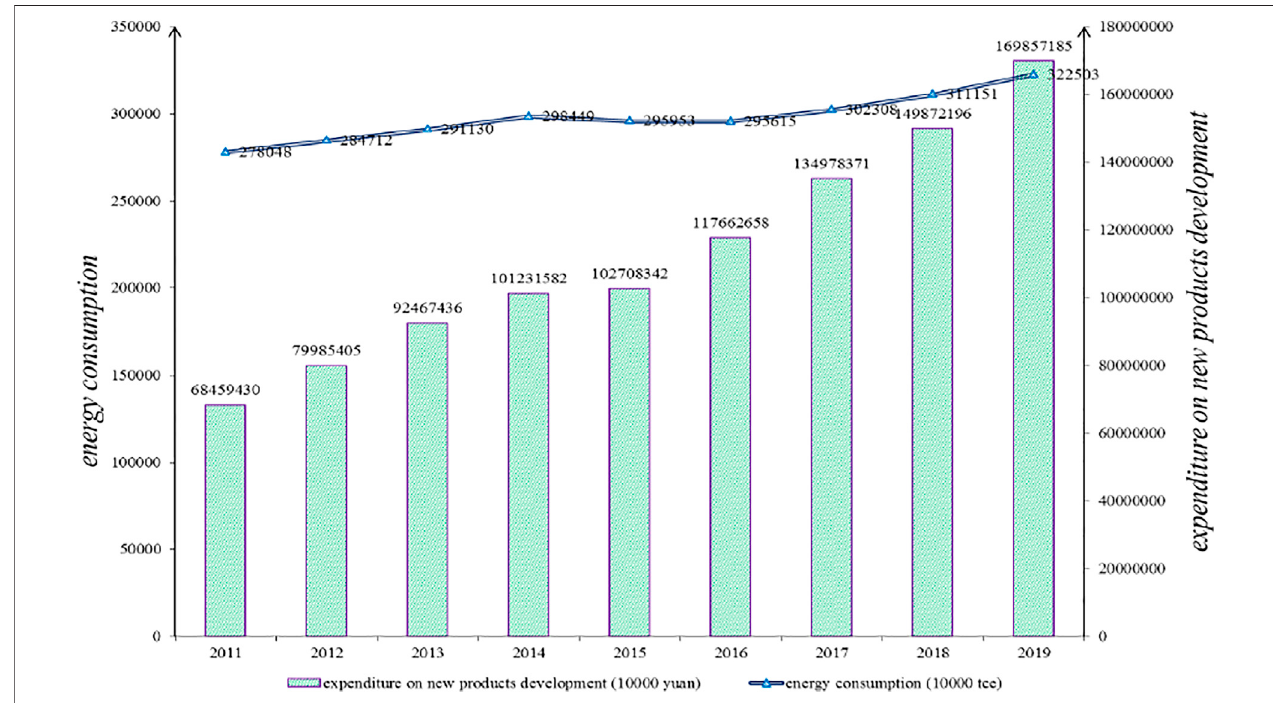
FIGURE 2 | Total energy consumption and expenditure on development of new products by the industrial sector in China during 2011 – 2019. Source: The author obtained the information from the China Statistical Yearbook and the China Energy Statistical Yearbook in the relevant years.